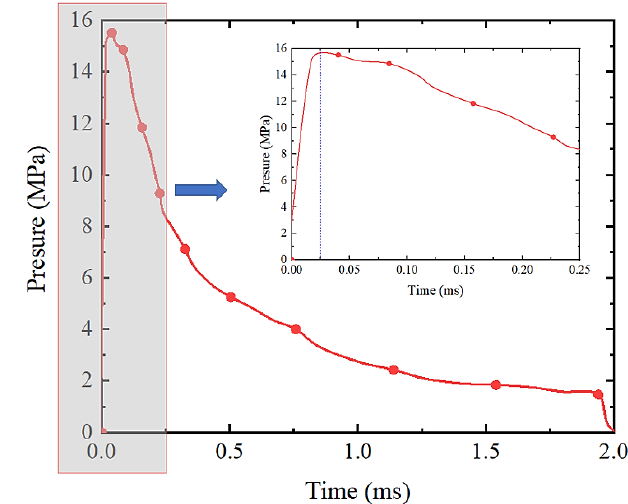
Figure 5. Shock Figure 5. Shock pulse.